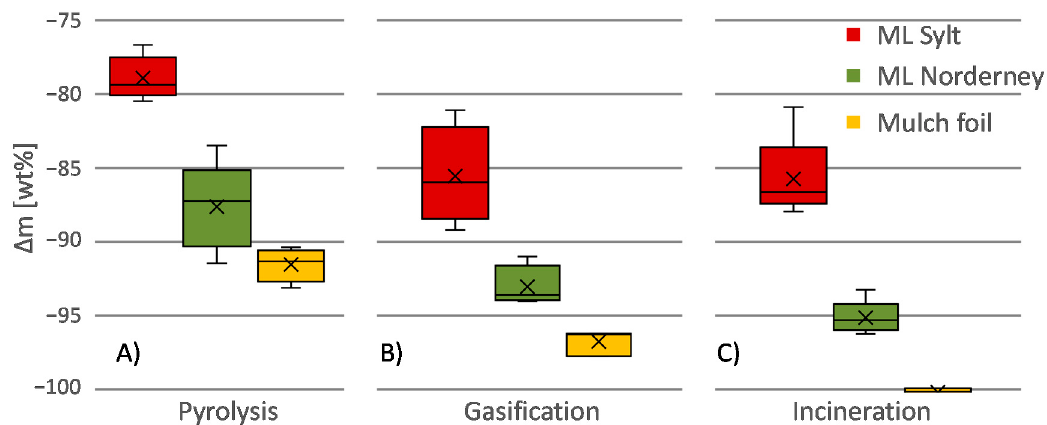
Figure 9. Comparison of determined sample mass constancy of all conducted TGA trials. ( A ) shows deviation for pyrolysis: ML Sylt n = 5, ML Norderney n = 5, Mulch foil n = 4. ( B ) shows deviation for gasification, ML Sylt n = 4, ML Norderney n = 4, Mulch foil n = 3. ( C ) shows deviation for incineration: ML Sylt n = 5, ML Norderney n = 5, Mulch foil n = 4.